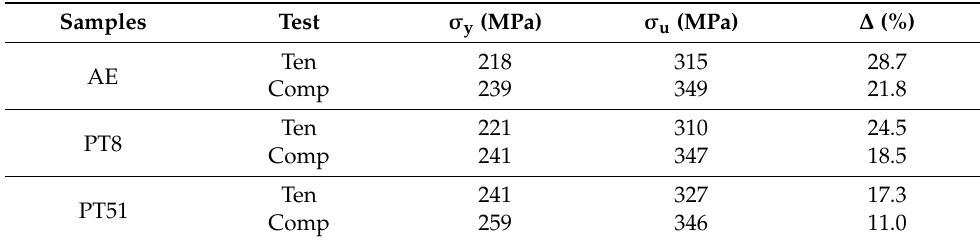
Table 1. Tensile mechanical properties of the